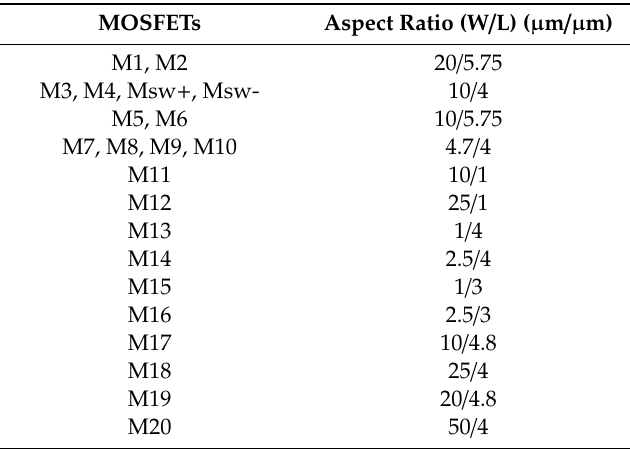
Table 1. Dimensions of the MOSFET devices used in the transmitter.